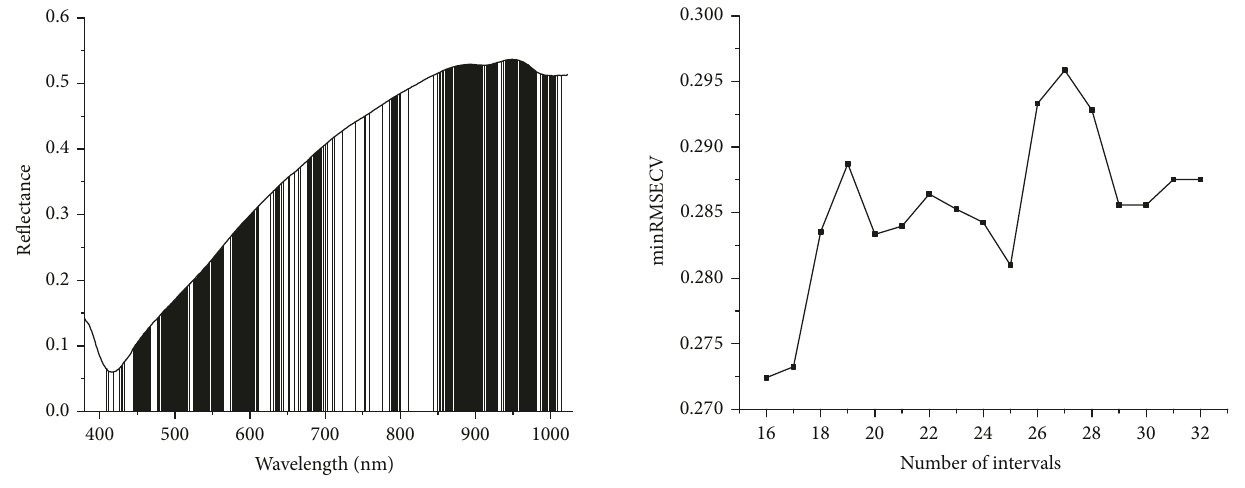
Figure 4: Plot of 291 selected wavelengths by UVE. Columns represent selected wavelengths.